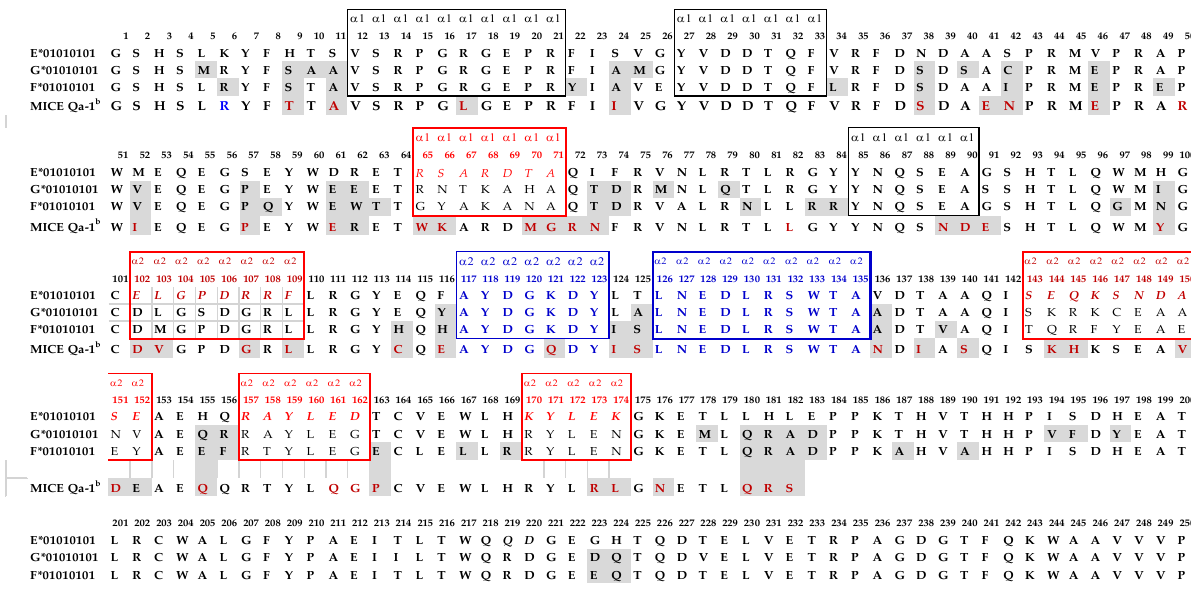
For HLA-A, HLA-B, and HLA-C LABScreen beatsets were tested, which carry both intact HLA (closed conformers) β2m-free heavy chain of HLA (open conformers). For HLA-E, HLA-F, and HLA-G fresh beads coated with β2m-free heavy chains (open conformers) were tested. 15 alleles of HLA-C coated on the microbeads of LABScreen beadsets.